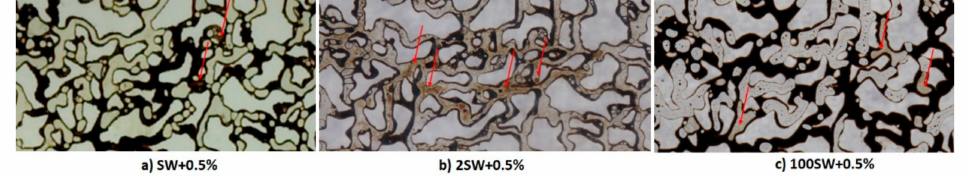
Figure 13. Selected sections of the oil-wet porous media during: ( a ) SW + 0.5%, ( b ) 2SW + 0 5%, ( c ) 100SW + 0.5%, flooding. The red arrows highlight the formation of micro-dispersion.